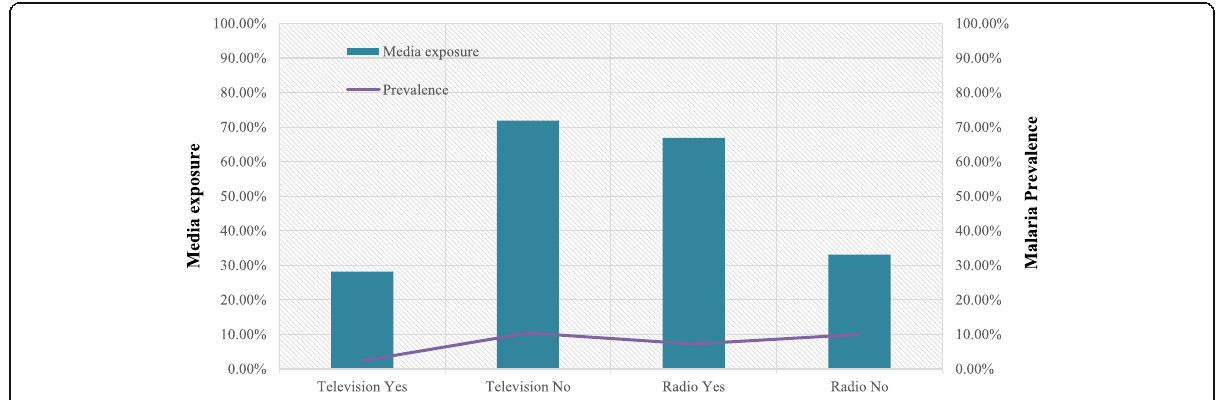
Fig. 1 Prevalence of malaria among media exposure and non-exposure households